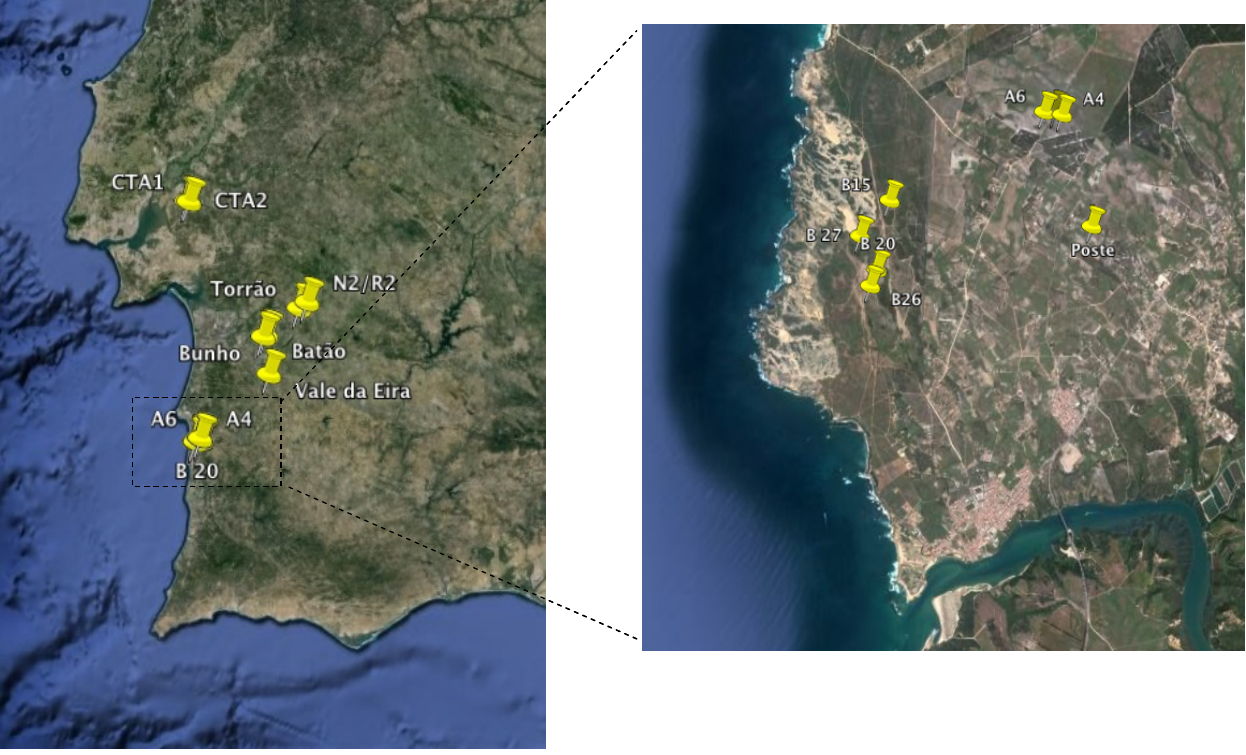
Figure 1. Location of the temporary ponds studied in southern Portugal (Google Earth v7.1. DigitalGlobe 2013).